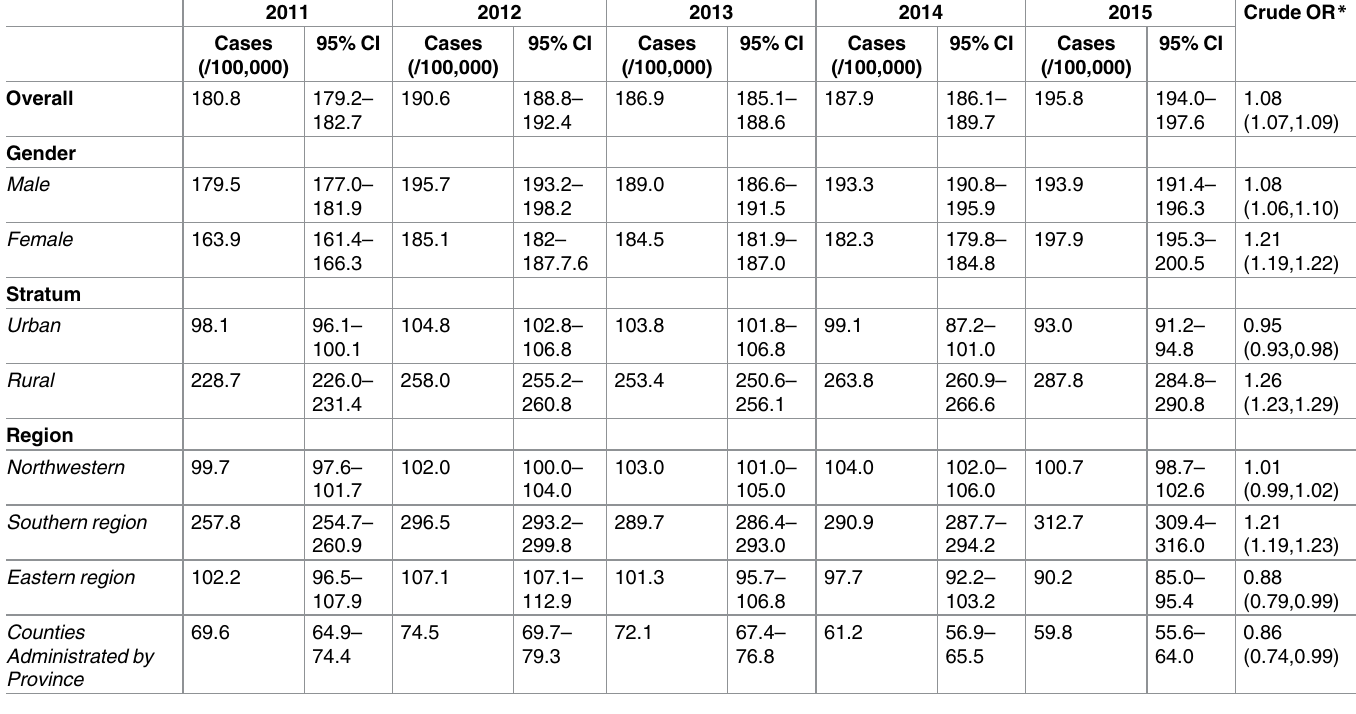
Table 2. Population level occurrence and trend of pulmonary tuberculosis in Xinjiang Uygur Autonomous Region, China,